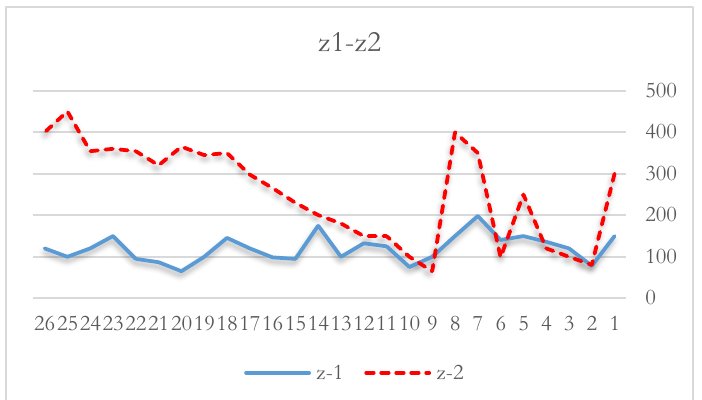
Fig. 7. Comparing the objective function before and after the distance is prolonged